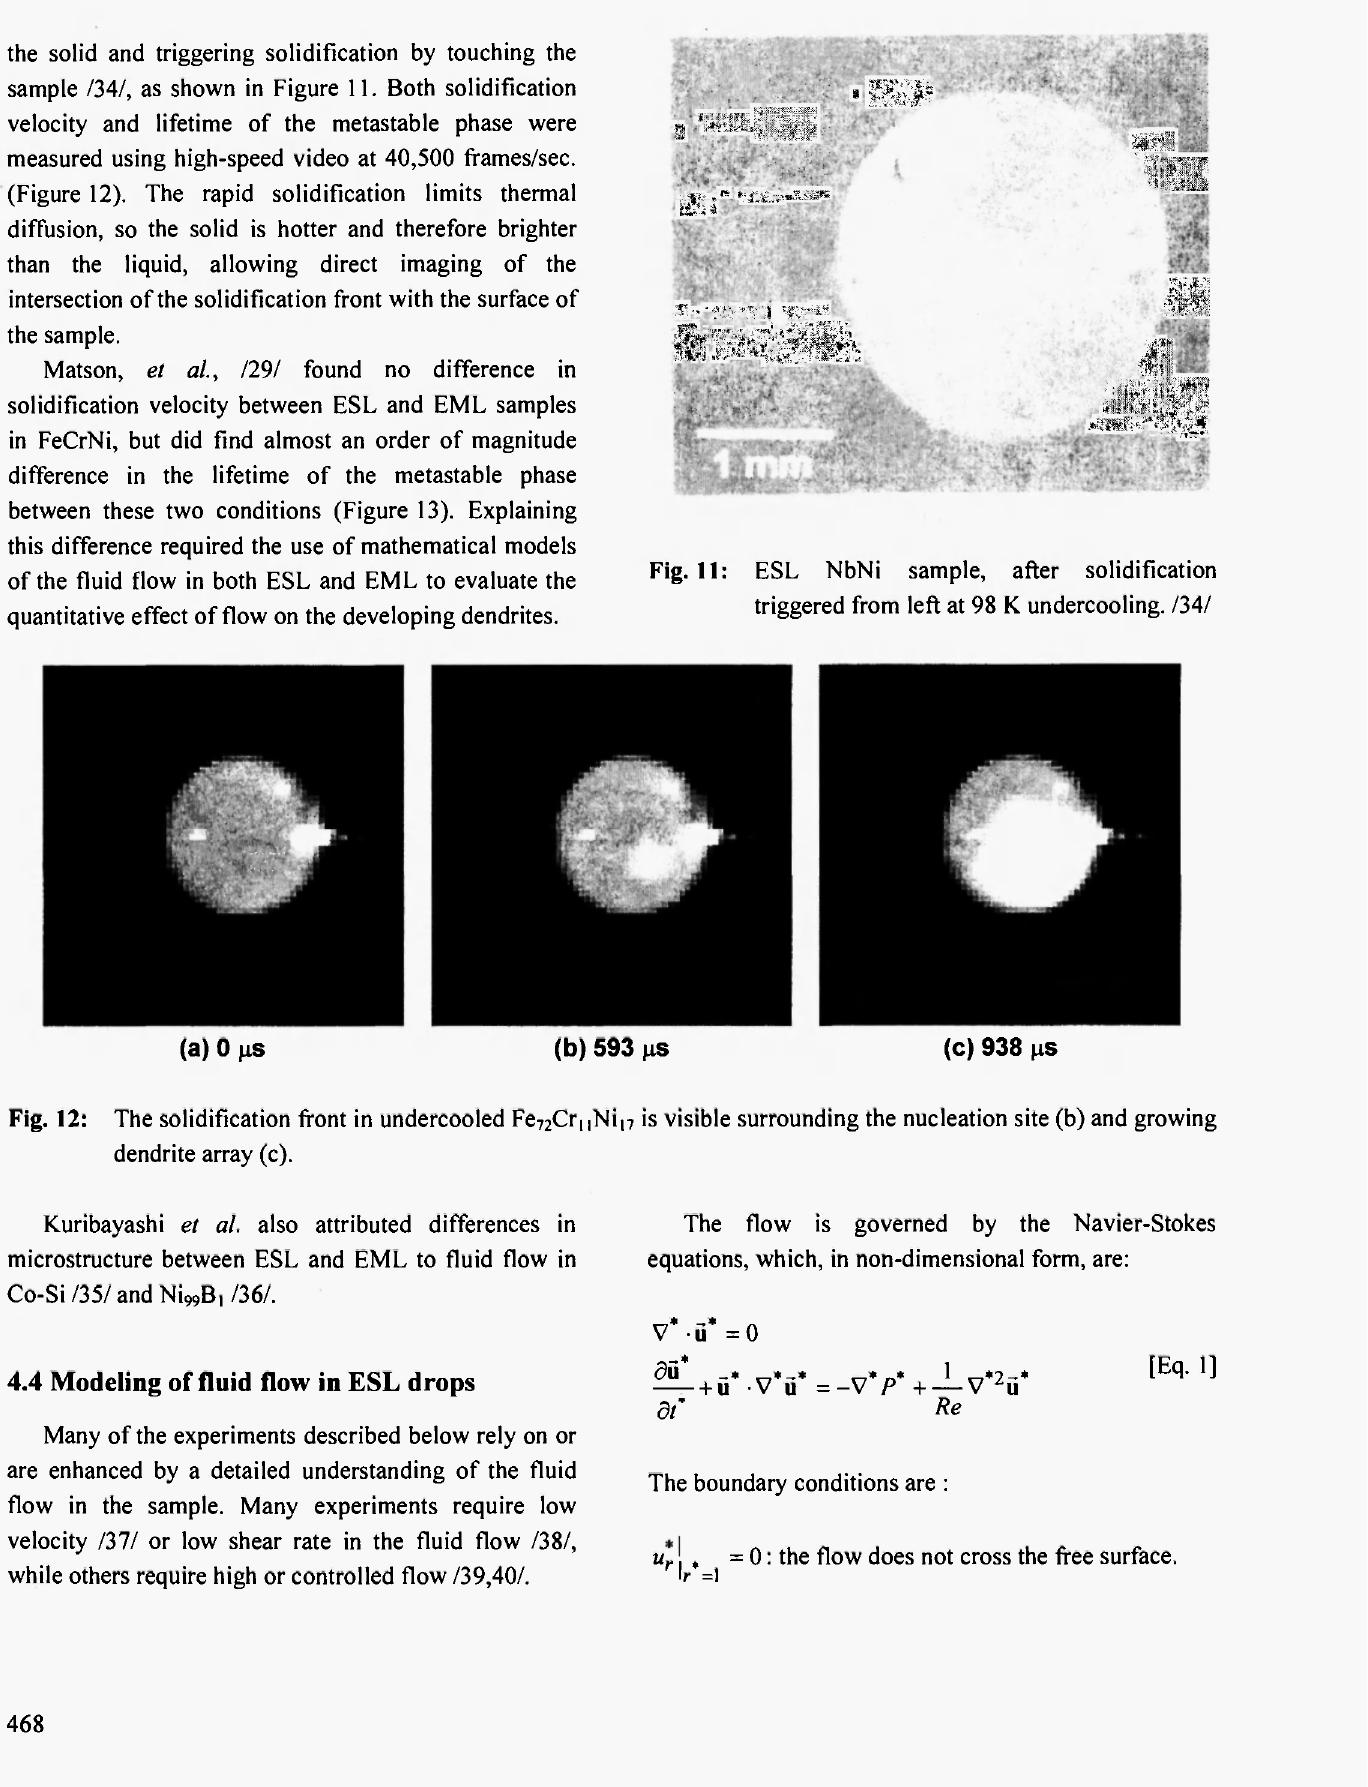
Fig. 11: ESL NbNi sample, after solidification triggered from left at 98 Κ undercooling. 734/